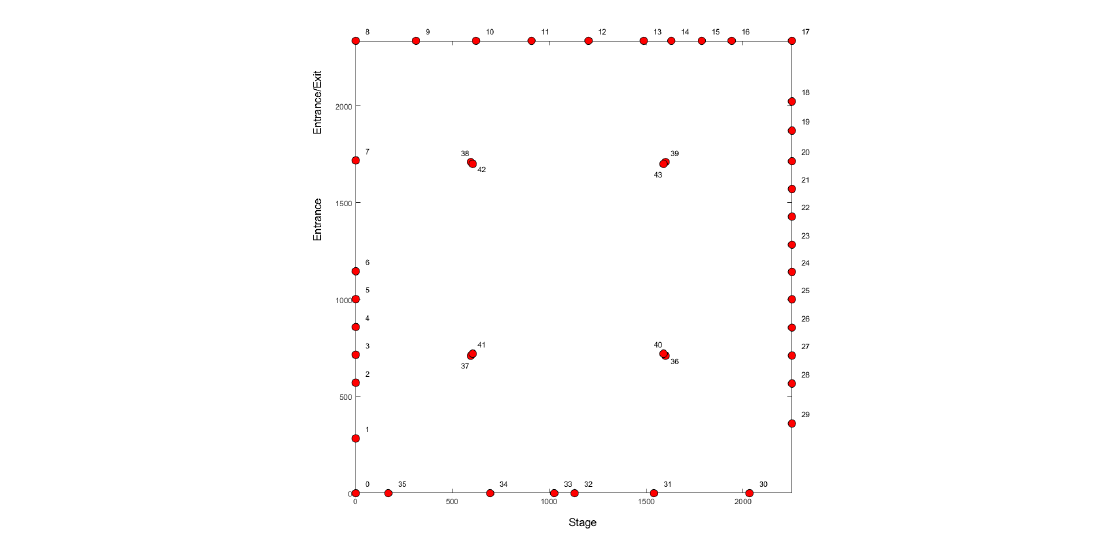
Figure 13. An overview of the Nucleus tent